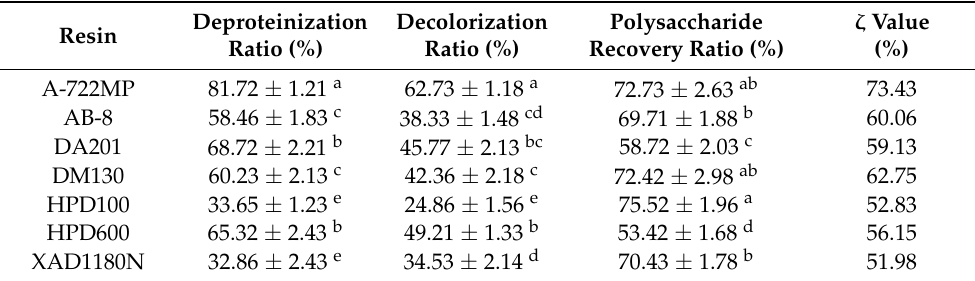
Table 2. Effect of seven different varieties of resin on deproteinization ratio, decoloration ratio, and polysaccharide recovery ratio.